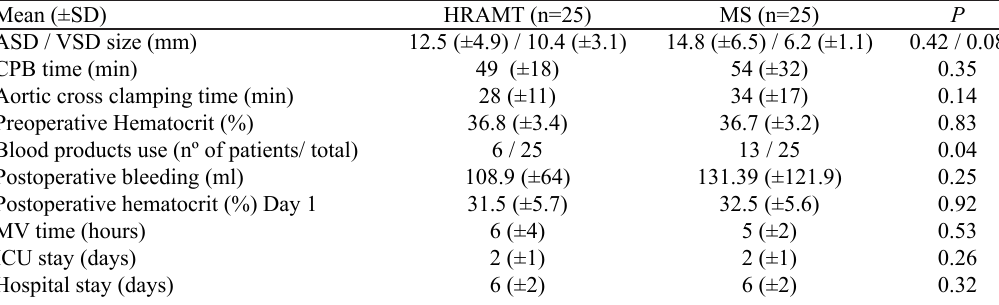
Table 2. Perioperative clinical data - groups